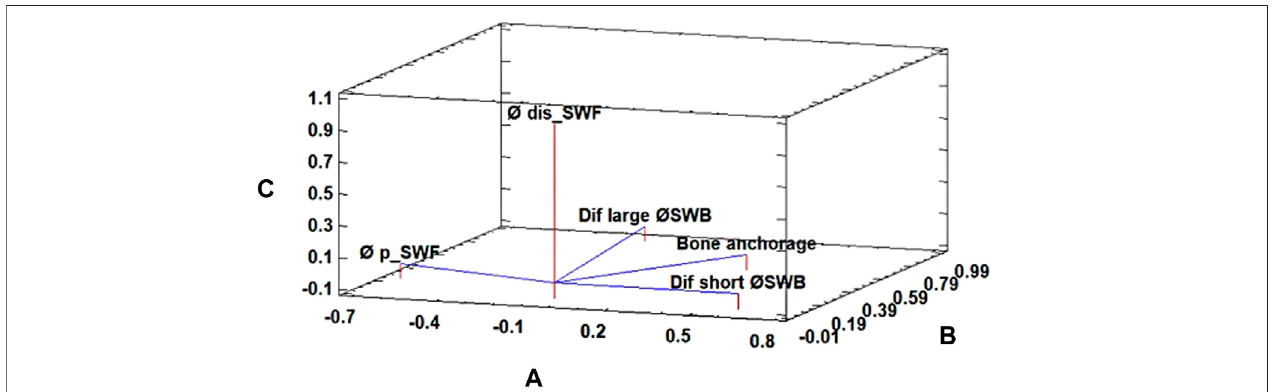
FIGURE4| Principalcomponent analysisfortheboneanchorageparameter of8.1/6subcategories oftheradii ’ PEEKplug.The fi rstthreecomponentsaccounted for44.14% (A) ,22.35% (B) ,and20.00% (C) ofthetotalvariation,respectively.Where “ DiflargeØSWB ” isexternallargeØdifferencebetweentheSolidWorks-designed plug (SW) and the bone, “ Dif short Ø SWB ” is external short Ø difference between SW and the bone, “ Øp_SWF ” proximal cavity Ø difference between SW and FunMat, and “ Ødis_SWF ” is distal cavity Ø difference between SW and FunMat.